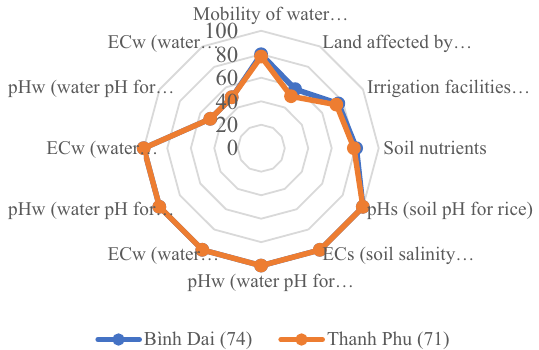
Figure 6. Stability theme